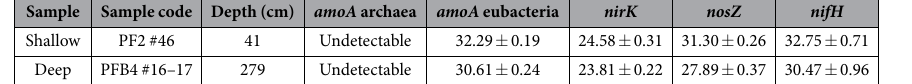
Sample Sample code Depth (cm) amoA archaea amoA eubacteria